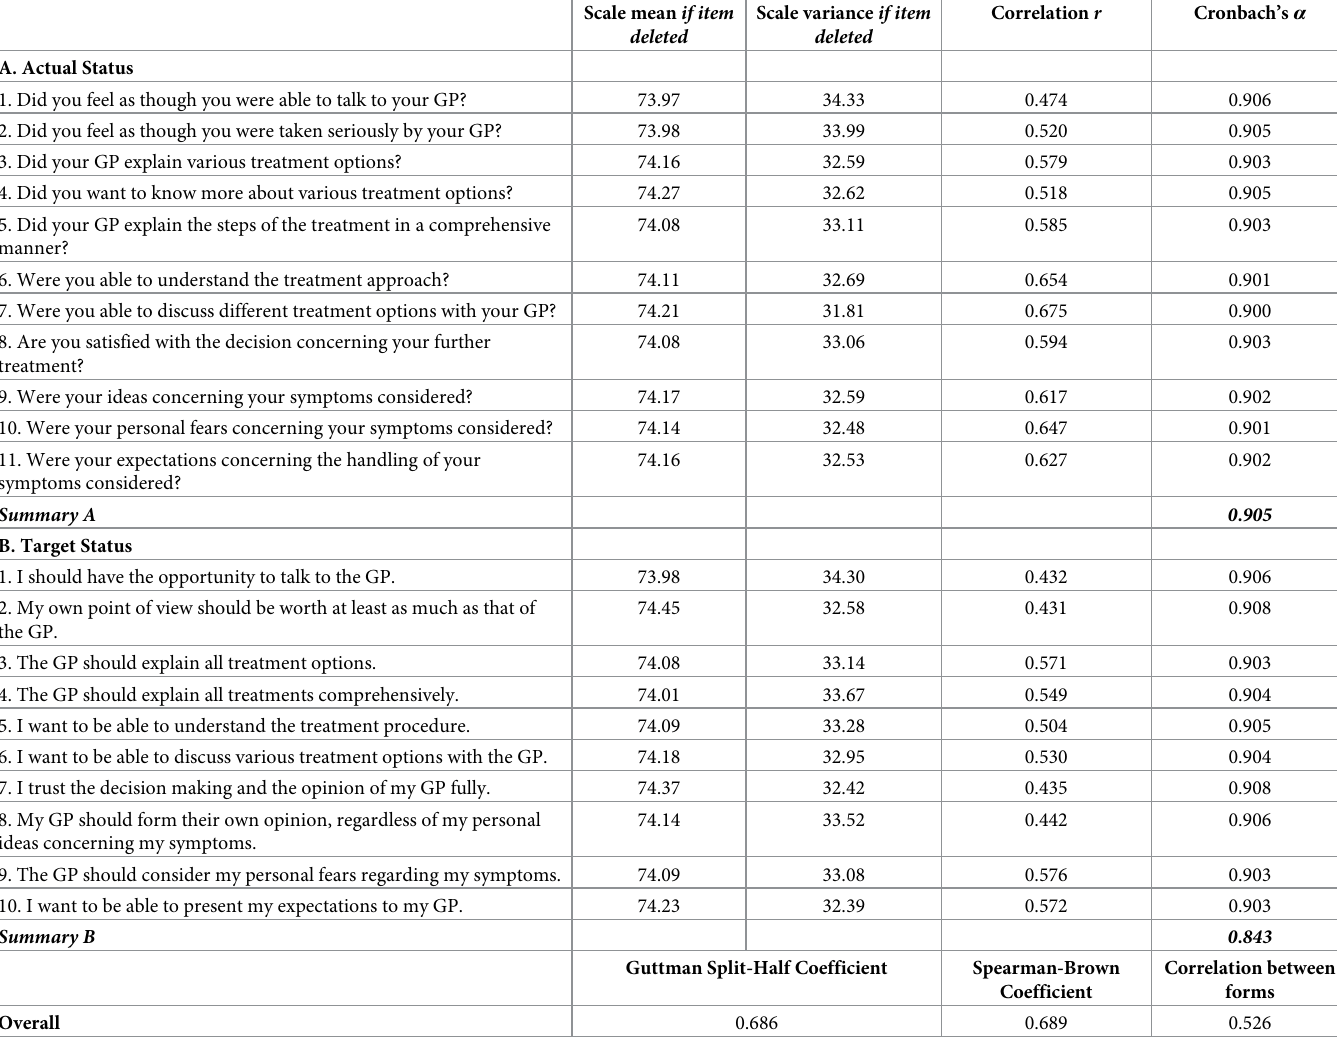
Table 4. Item statistics and correlation (Cronbach’s α ,